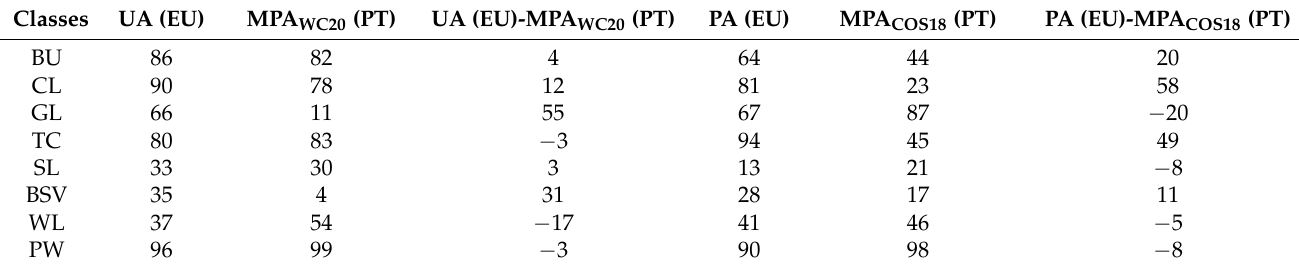
Table 5. WC20 user’s and producer’s accuracy per class reported for Europe (UA (EU) and PA (EU), respectively), and the MPA for WC20 when compared to COS18 and vice-versa, obtained for continental Portugal (MPA WC20 (PT) and MPA COS18 (PT), respectively), along with the differences between the comparable values when COS18 is used as the